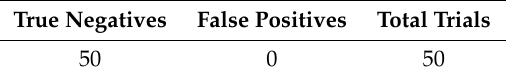
Table 7. Trials with users not registered in the